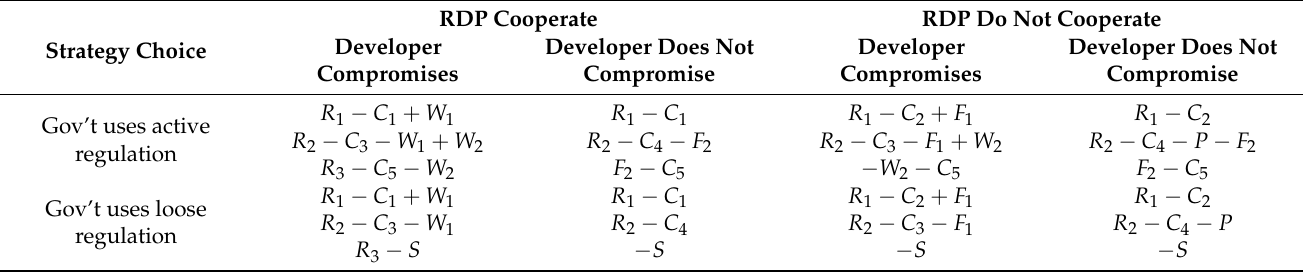
Table 7. Benefit matrix for the three-player